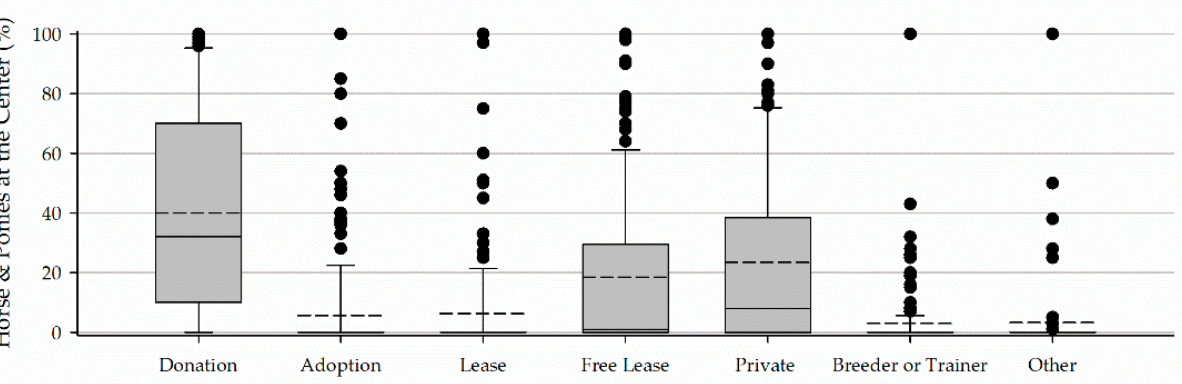
Figure 7. The percentage of horses and ponies at a center acquired from donation, adoption from rescues (adoption), lease, free lease, purchase from private owners (private), purchase from breeder or trainer (breeder or trainer), and other sources.